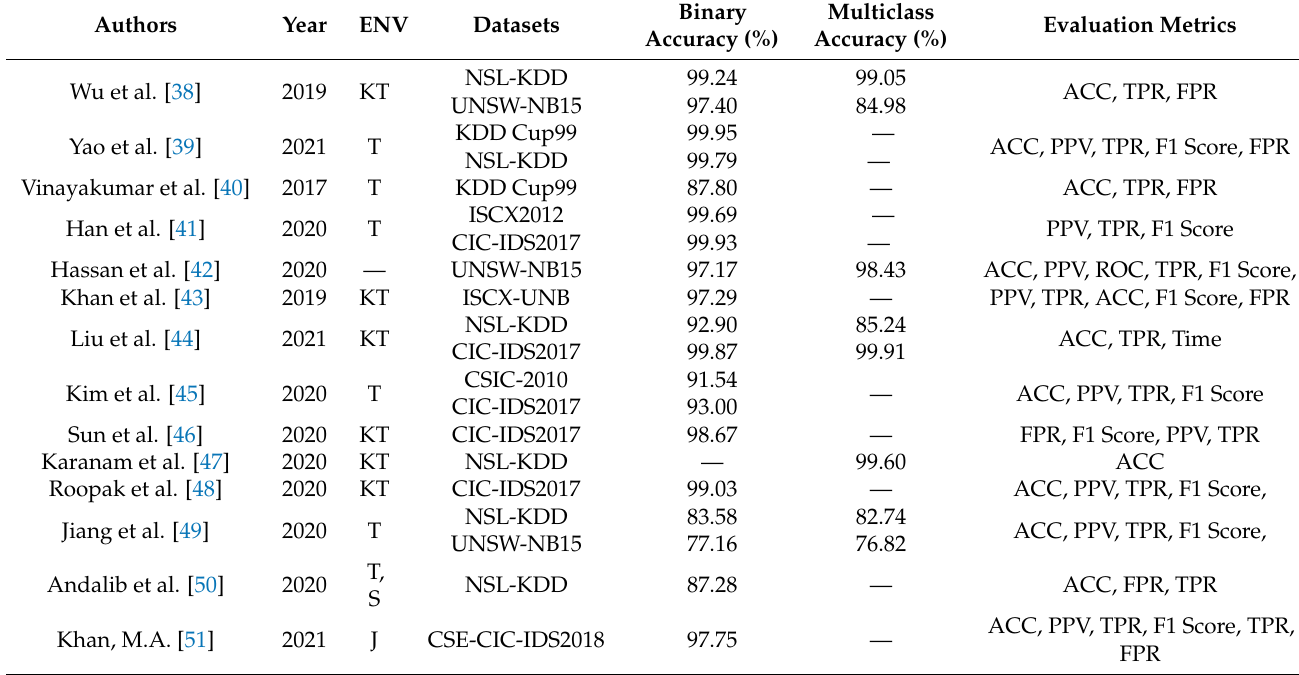
Table 7. Properties of group 2 (Hybrid CNN and RNN) IDS